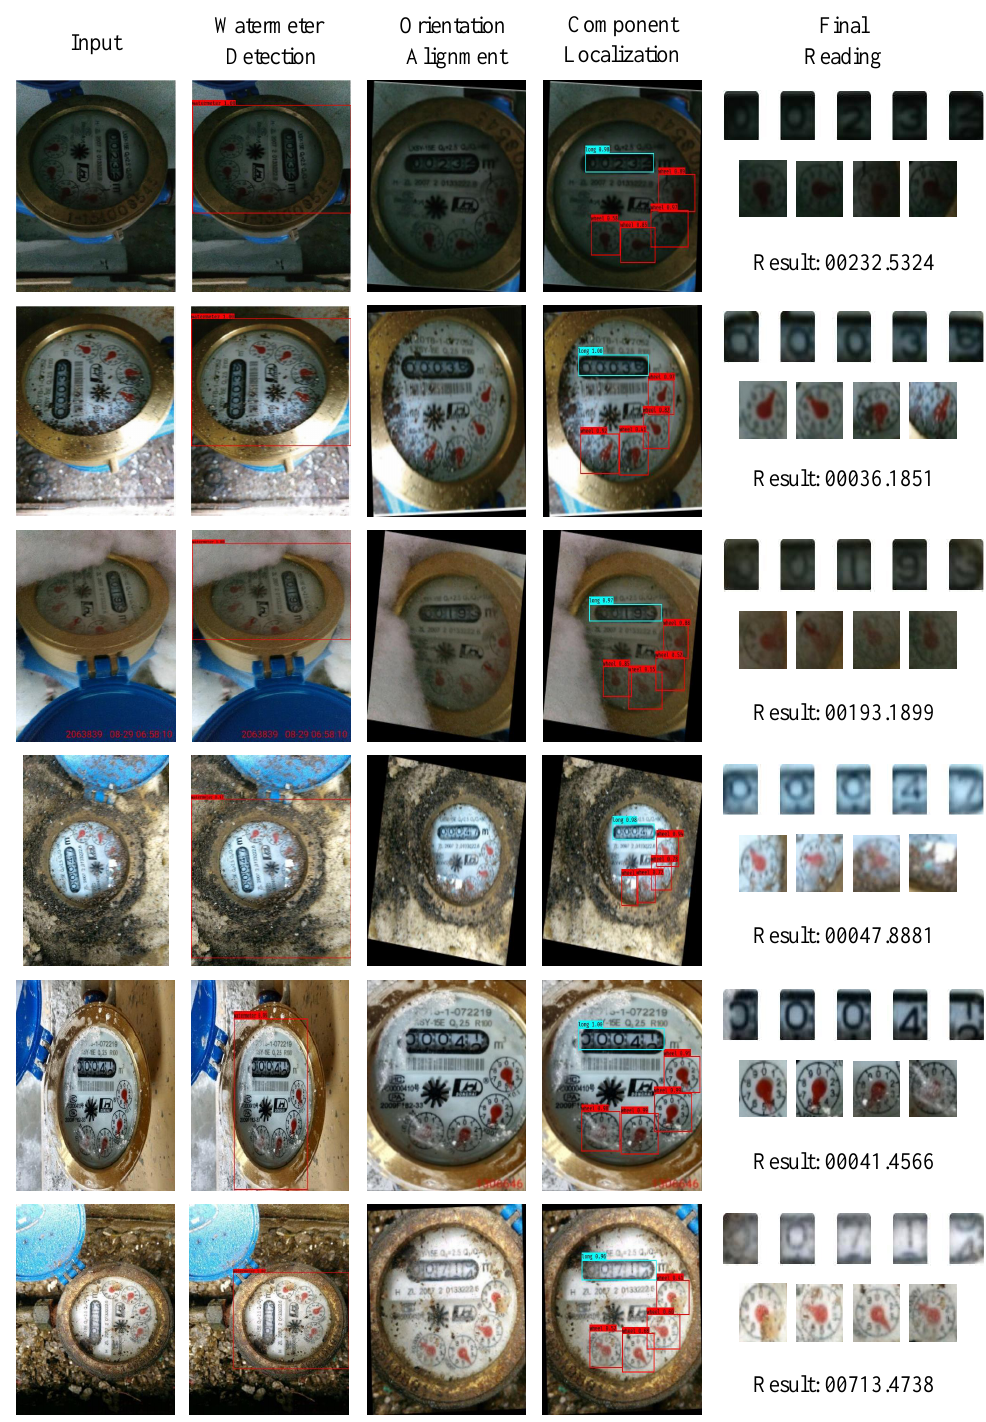
Figure 13. Performance test of the complete system: the first column is the input, the second to fourth columns are the intermediate results, and the last column is the final reading